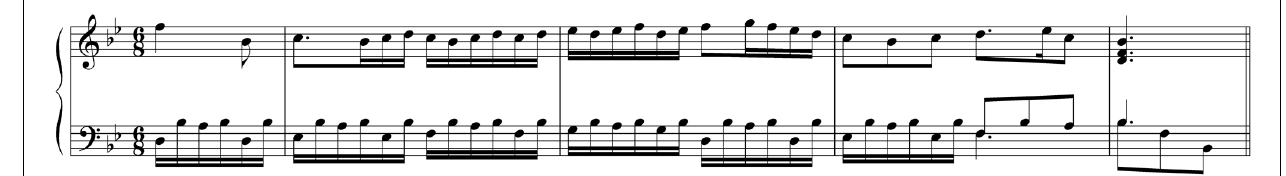
FIGURE 1 | Excerpt from Couperin’s Bergeries used in the sorting